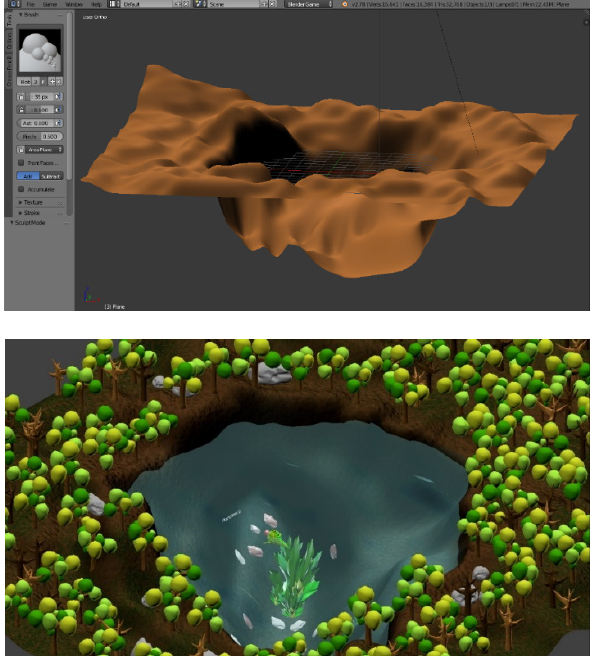
Fig. 8: Details of “Dive and Eat”. Above: The lake in “skulpt mode view” in Blender. Below: Final textured